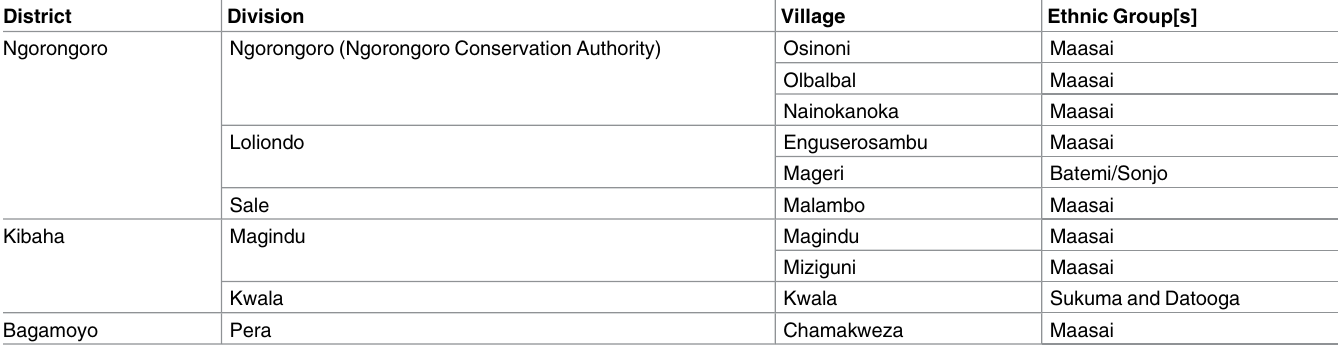
Table 1. Study sites and major pastoral ethnic